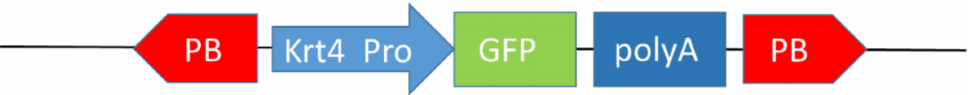
Figure 1. ET vector schematic. PB : two PB inverted terminal repeats (ITRs); Krt4 Pro: a minimal keratin4 promoter (the keratin4 minimal promoter from zebrafish); GFP : green fluorescent protein ORF; polyA: rabbit β -globin polyA signal.